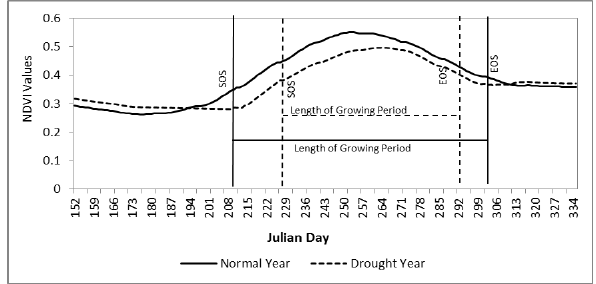
Figure 2 The NDVI profiles along with phenological parameters for drought and normal